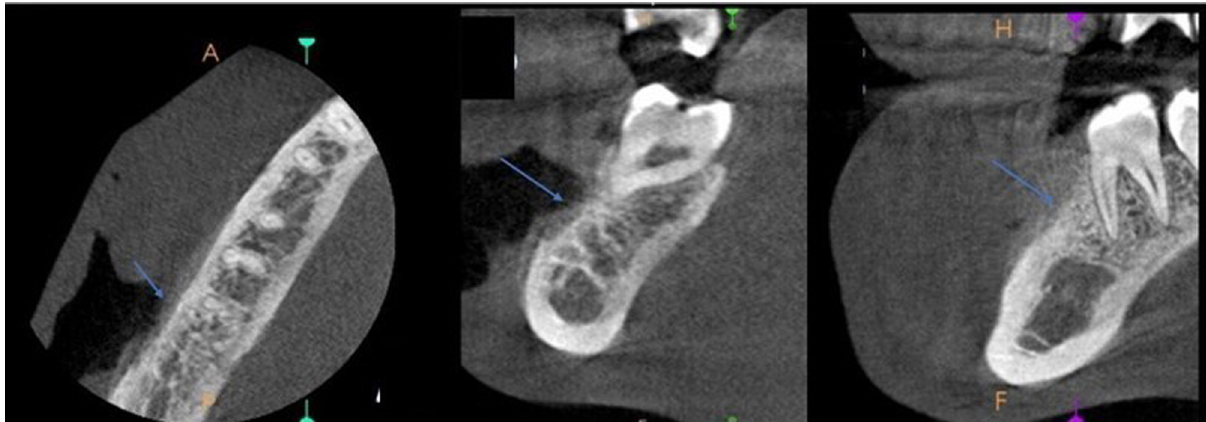
Fig. 3. Axial, coronal and sagittal sections of CBCT showing erosion of buccal and lingual